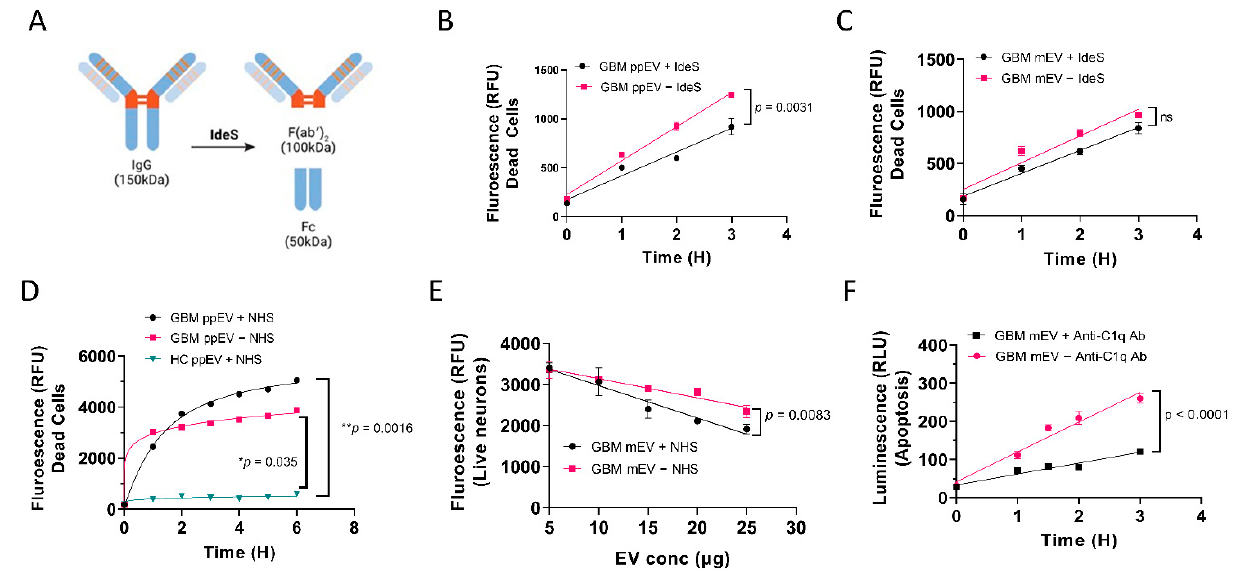
Figure 3. Reduced levels of GBM EV-induced neuronal cytotoxicity were observed by IgG digestion and complement elimination. ( A ). Schematic drawing showing digestion of IgG with the highly specific IgG cleaving enzyme IdeS. B-C. Reduced levels of cell death were observed in SH-SY5Y cells with IdeS-digested GBM EVs. GBM EVs were digested with IdeS before incubating with cells. ( B ). Significantly lower levels of cytotoxicity were found in cells treated with IdeS digested GBM pooled plasma EVs (ppEV) compared to undigested EVs ( p = 0.0031). ( C ). Although not significant, a similar trend was seen when treating cells with IdeS digested GBM cell line medium-derived EVs (mEV) compared to undigested EVs. ( D ). Normal human serum (NHS) enhanced GBM plasma EVs induced cytotoxicity in SH-SY5Y cells. GBM ppEVs (5 µ g/well) were added to cells with or without 5% NHS and the cytotoxicity was measured by green-fluorescent necrosis dye. NHS increased GBM ppEV cytotoxicity when compared to GBM ppEV treatment without NHS. However, without NHS, GBM ppEVs nonetheless induced elevated cytotoxicity compared to HC ppEVs. ( E ). Live cell counts post EV treatment. Human primary neurons were treated with GBM mEVs with or without 5% NHS. The cytotoxicity was measured using the live/dead assay (1 µ M Calcein AM/2 µ M Ethidium Homodimer1). Increasing GBM EV concentration produced fewer live cells, and NHS treatment enhanced the GBM EV cytotoxicity compared to samples without NHS ( p = 0.0083). ( F ). Blocking of complement component C1q with anti-C1q antibody inhibits GBM EV-induced apoptosis. Rabbit anti-C1q antibodies (4 µ g/well) were incubated with cells during GBM EV treatment. C1q antibody produced significantly lower levels of apoptosis in a time-dependent manner ( p <